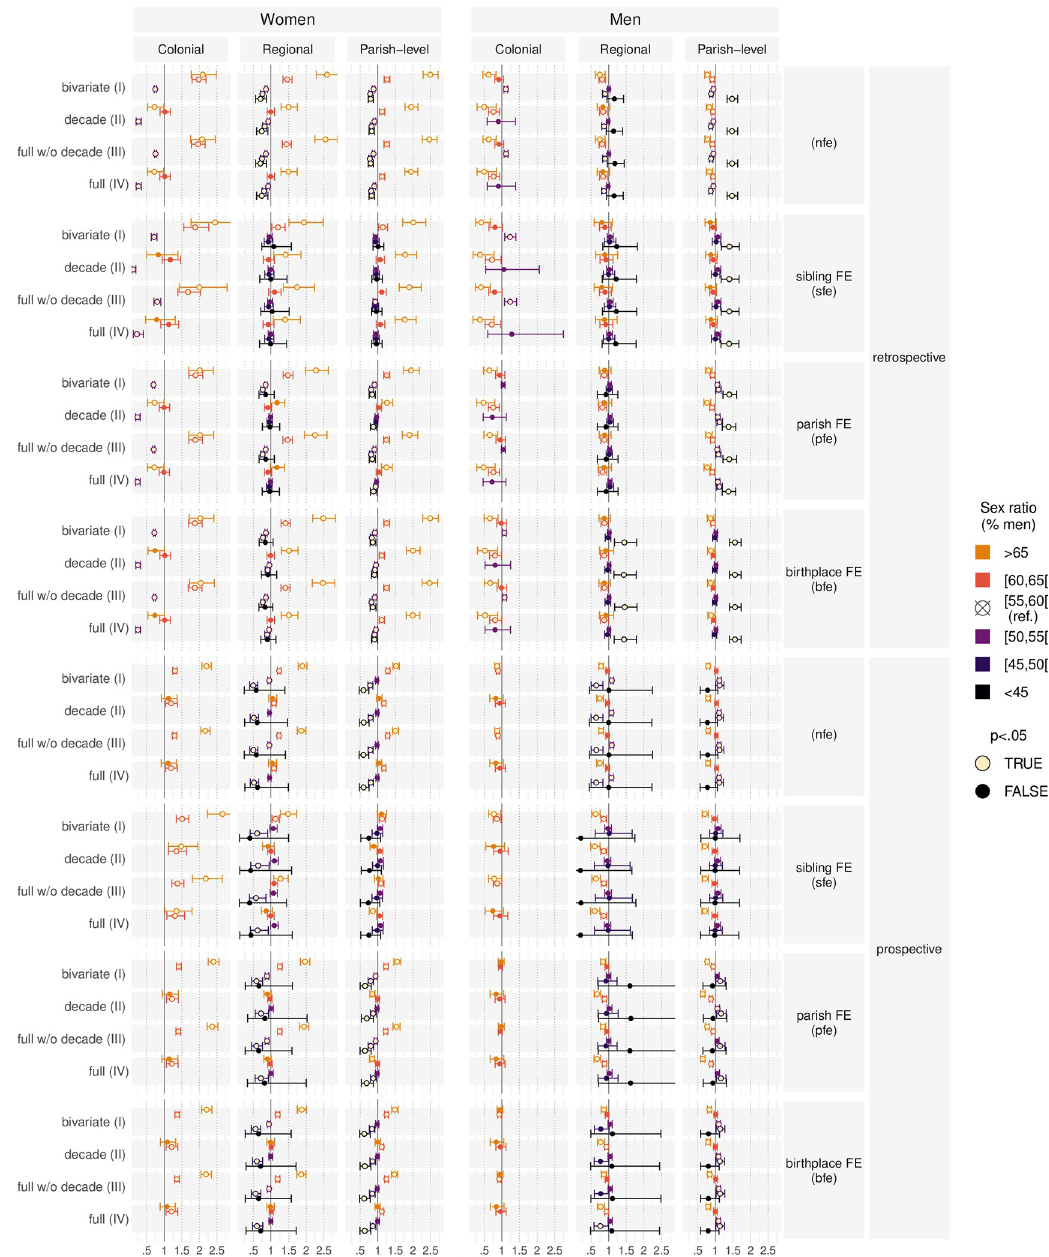
Fig 4. Hazard ratios from Cox proportional hazard models predicting transitions into first